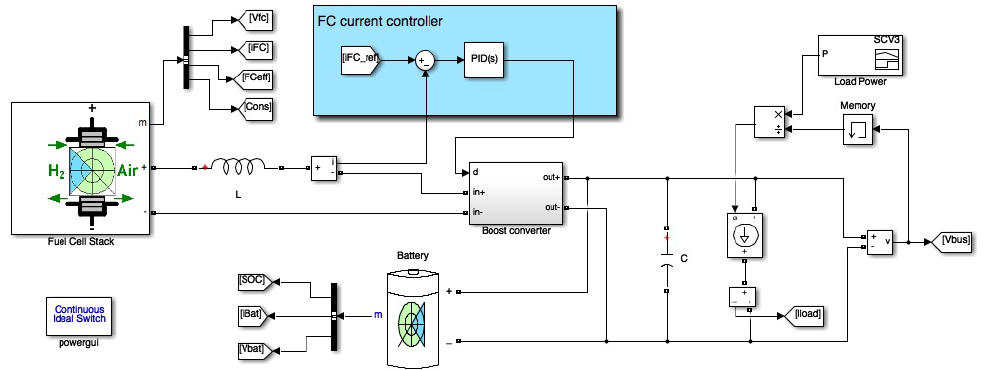
Figure 16. Semi-active hybrid power-train simulation circuit.